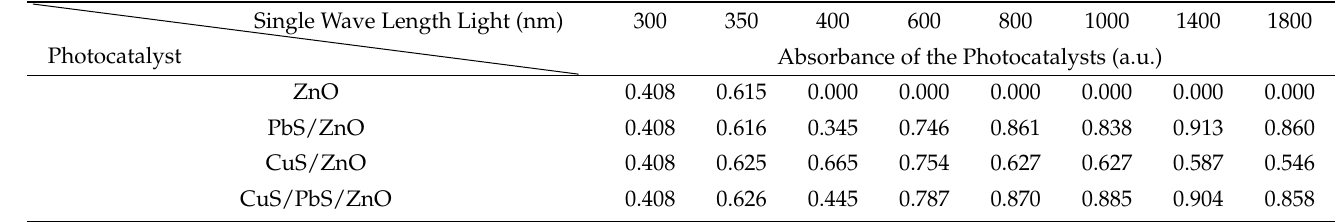
Table 1. Monochromatic light source to the contribution of each component in the photocatalyst. Single Wave Length Light Photocatalyst